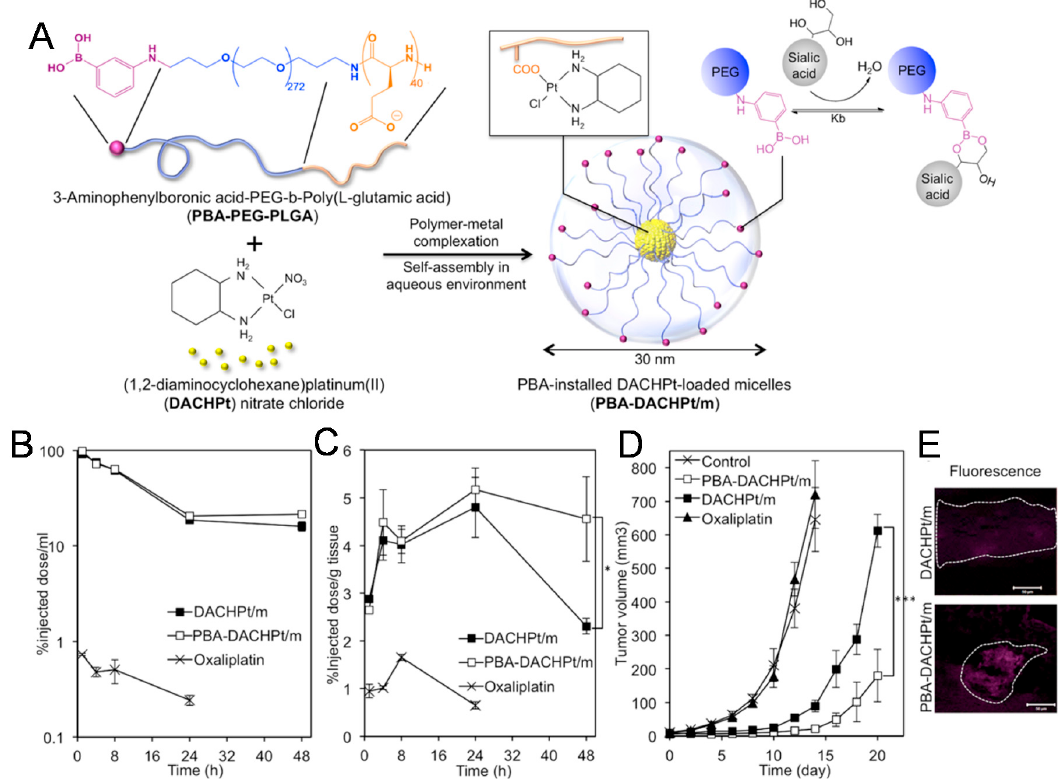
Figure 4. Small molecule-conjugated nanoparticles (NPs). ( A ) Scheme of phenylboronic acid (PBA)-conjugated dichloro-(1,2-diamino-cyclohexane)-platinum (II) (DACHPt)-loaded micelles (PBA-DACHPt/m) by self-assembly via polymer − metal complex formation. ( B ) Blood circulation time of intravenously injected DACHPt/m, PBA-DACHPt/m, and oxaliplatin. ( C ) Tumor accumulation of DACHPt/m and PBA-DACHPt/m in an orthotopic B16F10 mouse model. ( D ) Tumor volume of orthotopic B16F10 tumors after treatment with oxaliplatin (8 mg/kg), DACHPt/m, or PBA-DACHPt/m (3 mg/kg). ( E ) Ex vivo fluorescence images showing tumor tissue accumulation of DACHPt/m and PBA-DACHPt/m. Reproduced with permission from reference [44].